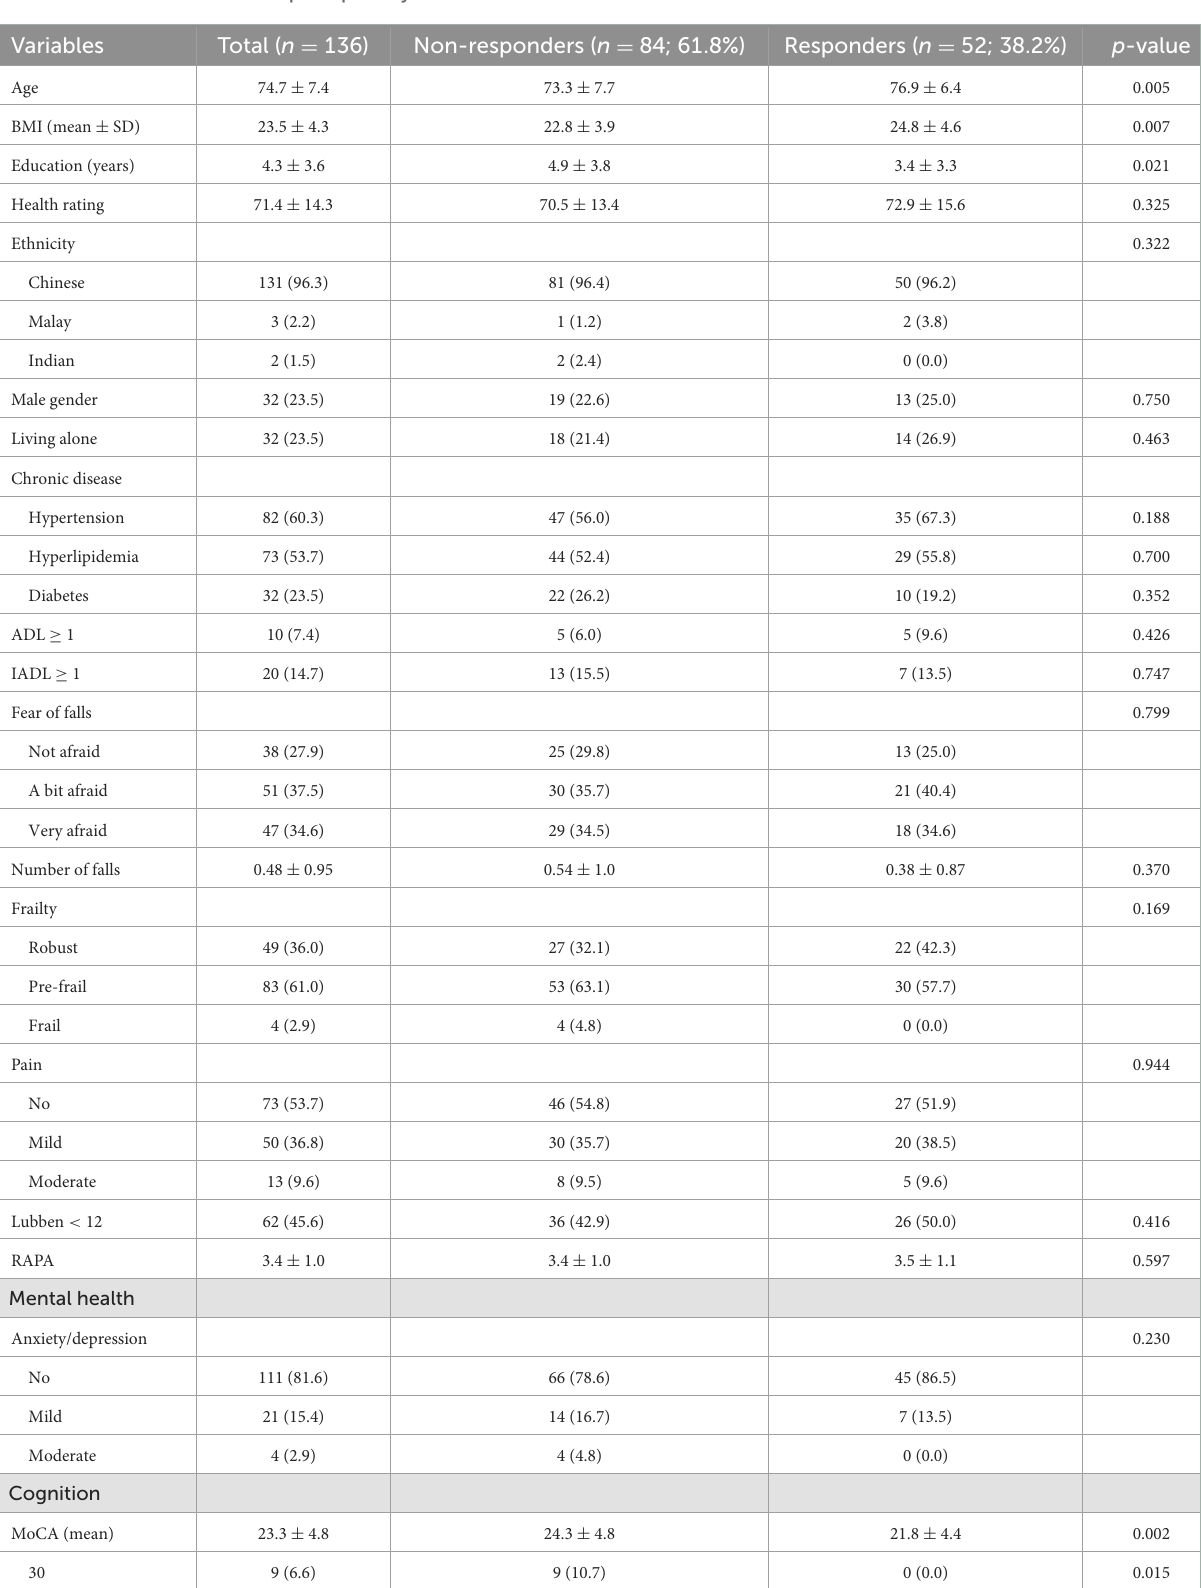
TABLE 3 Baseline characteristics of participants by